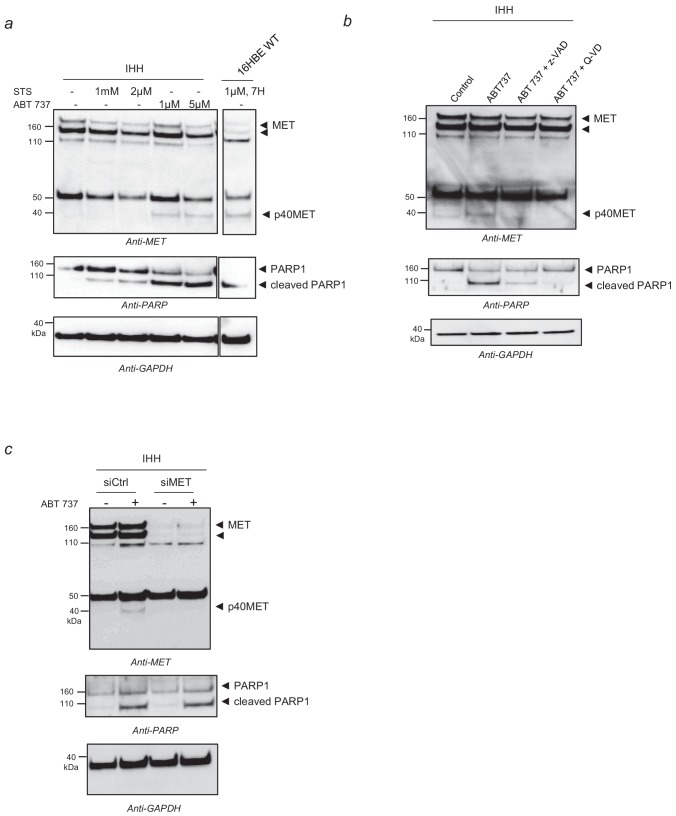
p40MET fragment generation in IHH cells.(a) IHH hepatocyte cells were cultured for 24 hr on 6 well plates coated with collagen. Cells were then starved overnight in a serum-free medium and treated 7 hr with staurosporine (STS) or ABT 737 at the indicated concentration before cell lysis. As a positive control, 16HBE epithelial pulmonary cells were starved overnight in a serum-free medium and treated 7 hr with staurosporine (STS) at the indicated concentration before cells lysis. (b), IHH cells were cultured for 24 hr on 6 well plates coated with collagen. Then cells were starved overnight in a serum-free medium and treated 7 hr with 1 µM ABT 737 with or without the pan-caspase inhibitor zVAD-FMK or Q-VD (20 µM). (c) IHH cells were transfected with a control siRNA or a pool of three MET-targeting siRNAs for 48 hr on 12 well plates coated with collagen. Cells were then treated 7 hr with ABT 737 (1µM) before cells lysis. The same amount of proteins was resolved by SDS-PAGE and analyzed by immunoblotting with antibodies against the MET kinase domain, PARP, to assess apoptosis induction, and GAPDH, to assess loading.